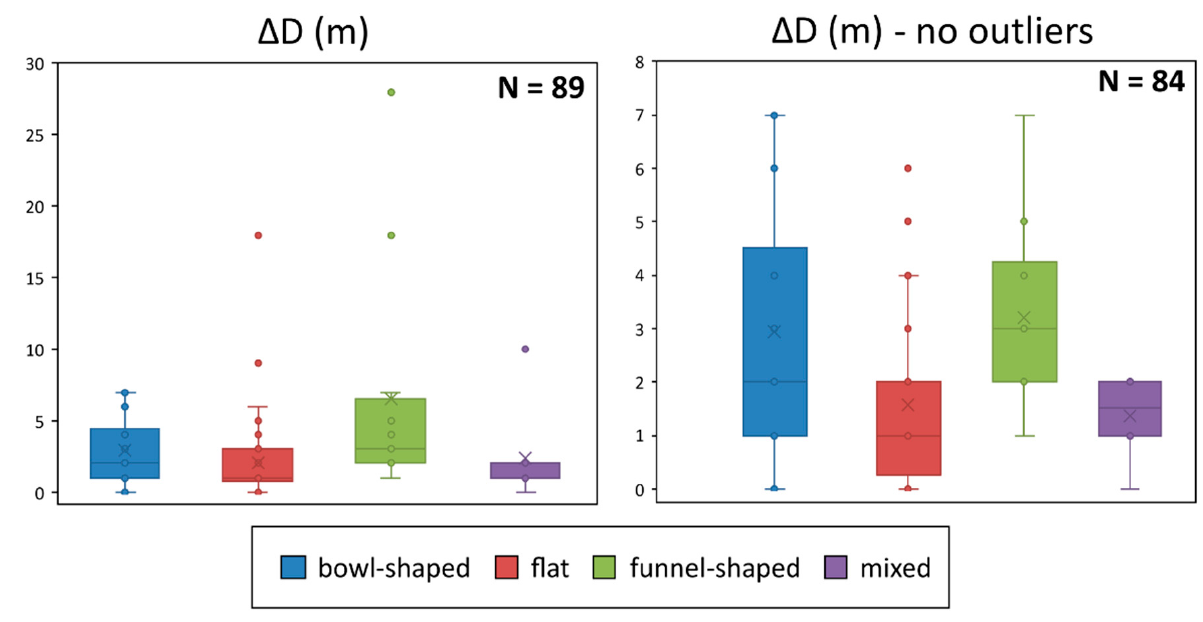
Figure 8. Boxplots of the difference between depth (D) values from field- and DEM-derived measurements for the entire population ( left ) and a subset without outliers ( right ). The boxplots are grouped according to doline shape. The limits of the boxes and whiskers represent the first and third quartiles, respectively. The straight lines inside the boxes represent the median values and the crosses represent the mean values.